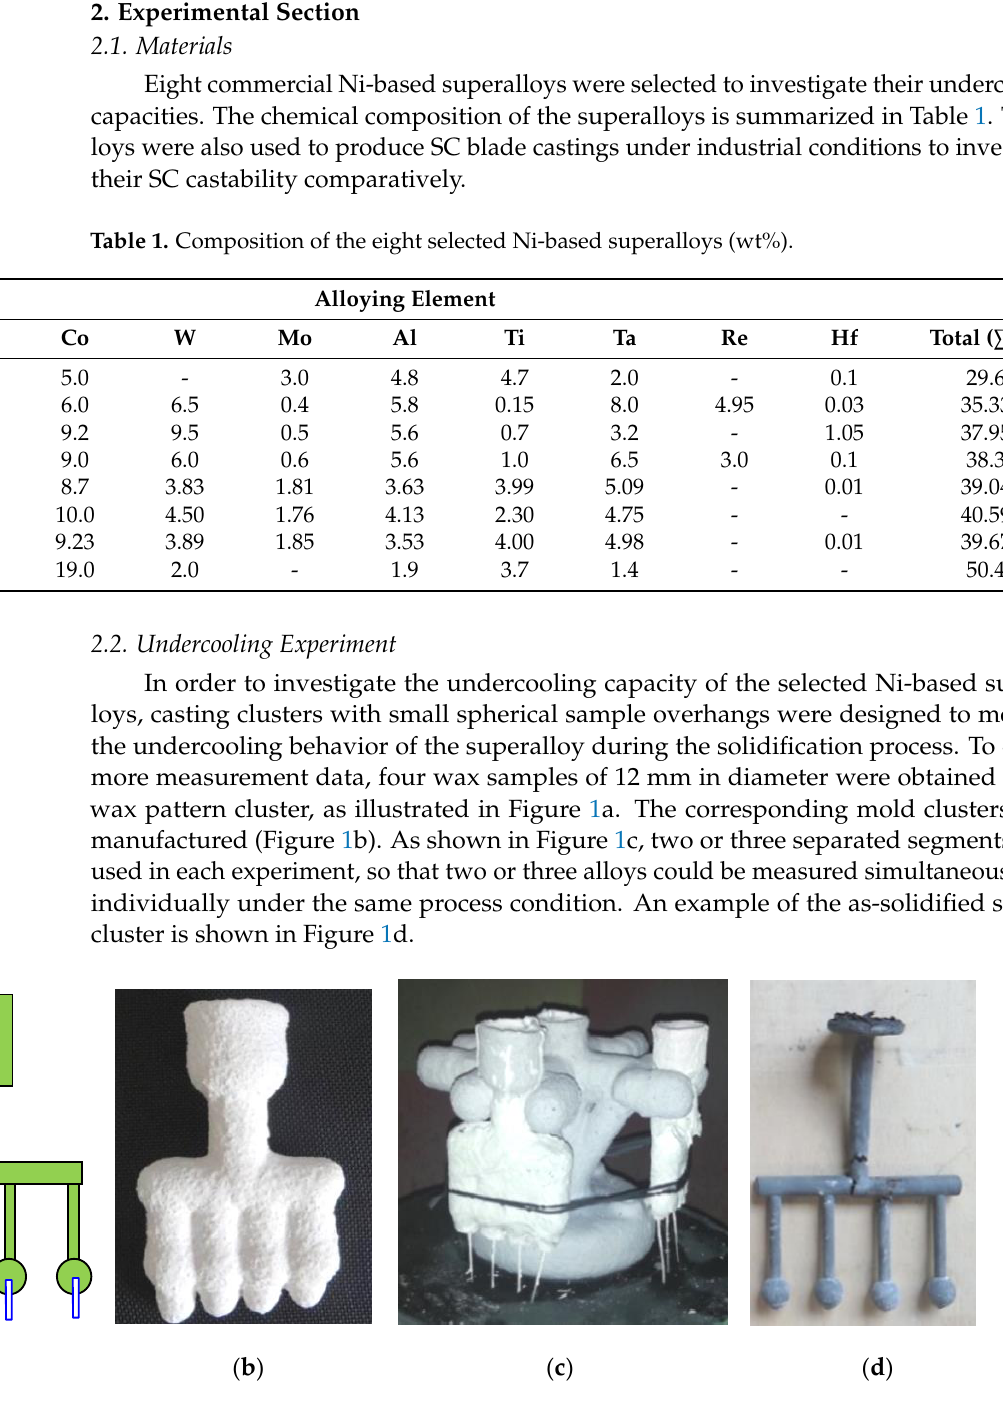
Figure 1. ( a ) Wax pattern cluster; ( b , c ) the corresponding shell mold and assembly; ( d ) solidified samples after experiment.